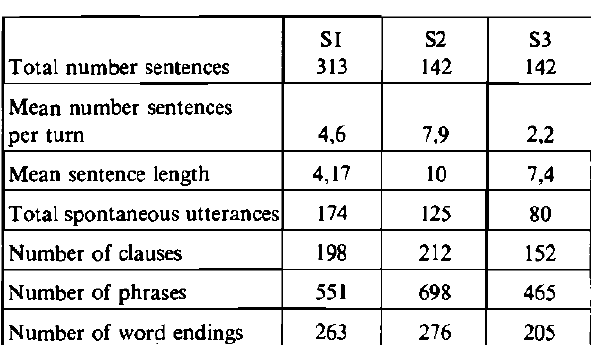
Table 4: Results obtained by all subjected on the Revised LARSP profile (Crystal 1982).